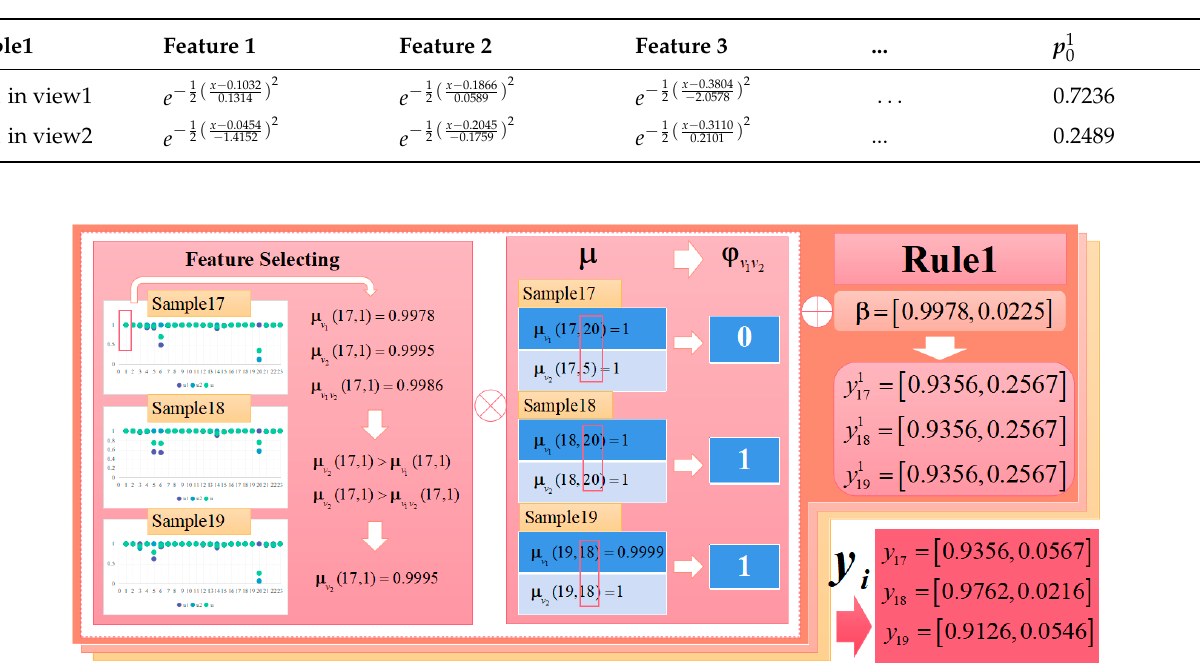
Figure 9. Comparison between TMV-TSK-FC and different decision coefficient matrix algorithms.